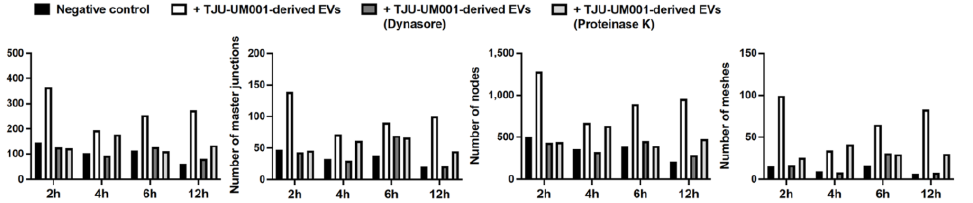
Figure A2. Dynasore and proteinase K pretreatments prevented UM-derived EV internalization in endothelial cells and inhibit the formation of capillary-like tubes. Untreated GFP-HUVECs were cultured for 12 h on Matrigel ® with medium without angiogenic factors (negative control; black bars). Large EVs isolated from metastatic UM cell line TJU-UM001 were added to GFP-HUVECs for 24 h before their seeding on Matrigel ® for 12 h (white bars). GFP-HUVECs were also pretreated with Dynasore (dark grey bars), or TJU-UM001-EVs were pretreated with proteinase K (light grey bars) as controls. The number of junctions, master junctions, nodes, and meshes were quantified in function of time (hours) for each condition ( n = 1).